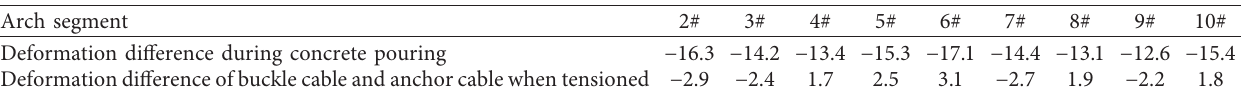
Table 1: Deviation between the measured deformation value and the target deformation value (measured deformation minus target deformation) (mm).